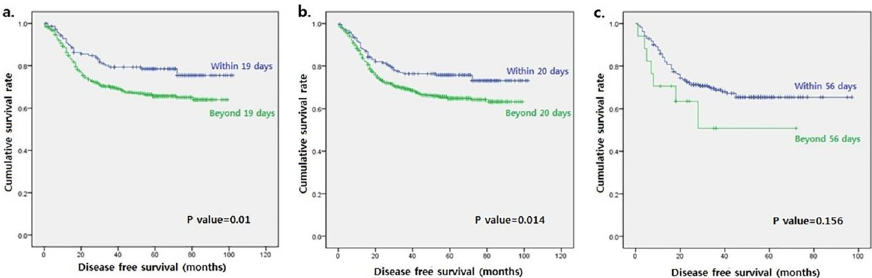
Fig 2. Kaplan–Meier curves for disease-free survival among all the patients (a), patients treated without preoperative chemo-radiotherapy (b), and patients treated with preoperative chemo-radiotherapy (c). Comparisons of patients who initiated adjuvant chemotherapy within the cut-off point (blue line) and beyond the cut- off point (green line).